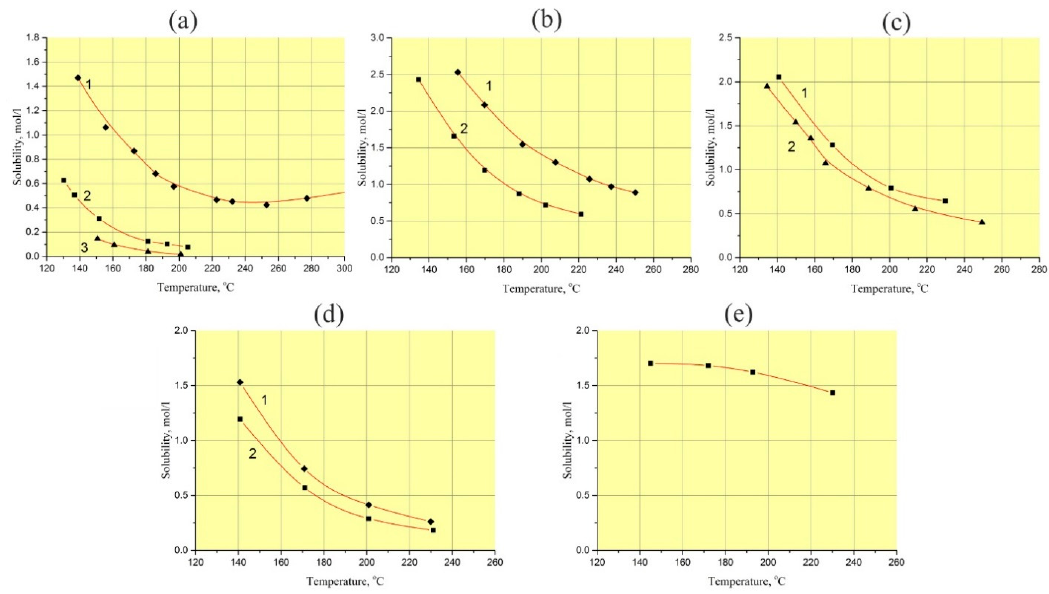
Figure 1. Solubility of GaPO 4 in aqueous solutions (at pressure of 5–20 bar): ( a ) H 3 PO 4 , 1–15 M , 2–7.5 M , 3–5 M ; ( b ) H 2 SO 4 , 1–9 M , 2– 6.5 M ; ( c ) 15 M H 3 PO 4 /9 M H 2 SO 4 in vol. proportions (%): 1–20/80, 2– 50/50; ( d ) 9 M H 3 PO 4 /6 M H 2 SO 4 in vol. proportions (%): 1–20/80, 2–70/30; ( e ) 6 M HCl